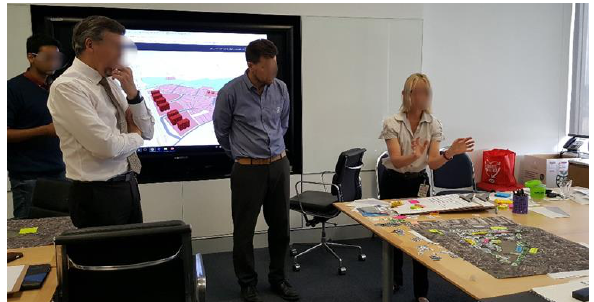
Figure 7. Importance rating of PSS measures in the Blacktown